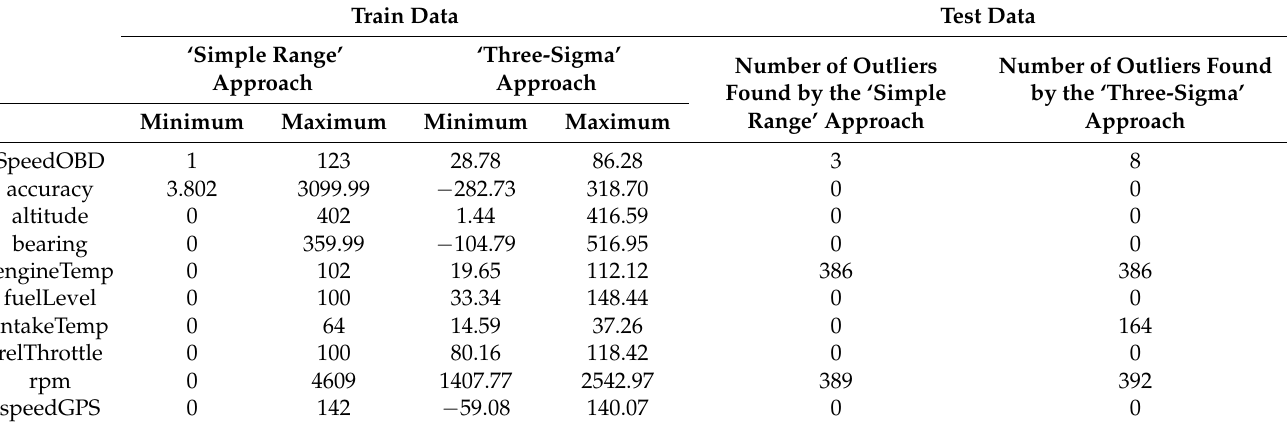
Table 4. Results of simple and three-sigma approach, as well as outliers detected in the numerical data. Train